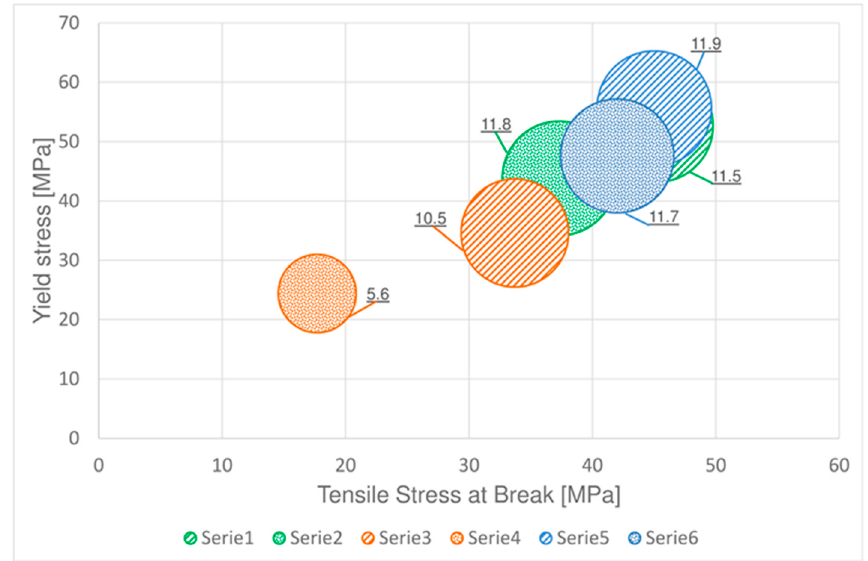
Figure 10. Comparison of tensile and fatigue strength at different temperatures, the circle diameters represent the fatigue limit in MPa.